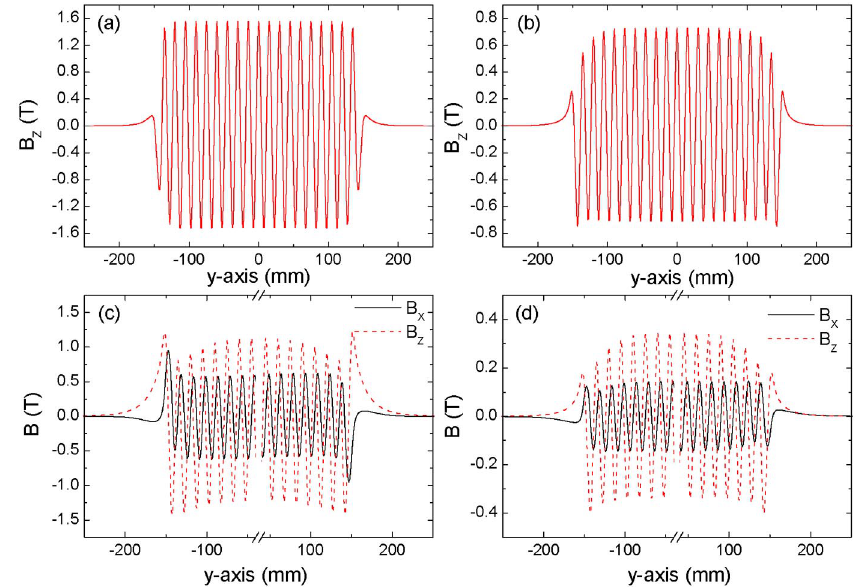
FIG. 2. (Color) Distribution of magnetic-flux density along the longitudinal y axis of the linearly polarized undulator in (a) the racetrack coil structure, (b) the staggered structure, and the elliptically polarized undulator in (c) the racetrack coil structure and (d) the staggered structure. The selected angles of rotation of the vertically wound racetrack coil and staggered undulator are 35 (cid:2) and 25 (cid:2)